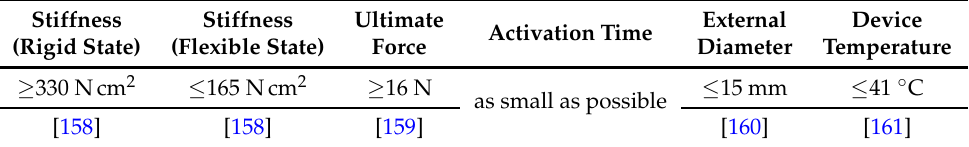
Table 2. Requirements for a variable stiffness device applied to endoscopic applications. The values are indicative, give mainly an order of magnitude and may depend on specific requirements related to particular